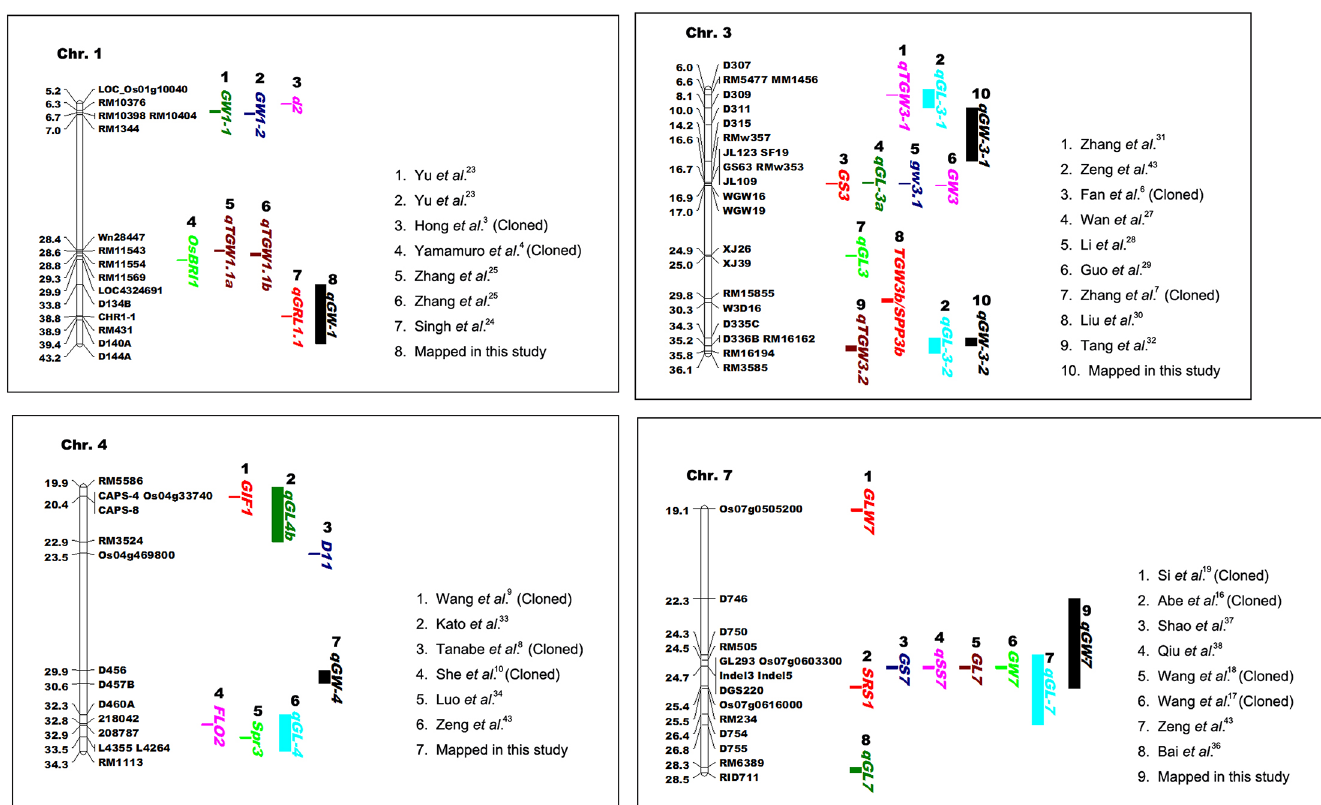
Fig 3. Comparison of the grain-shape- or grain-weight-related genes mapped on chromosomes 1, 3, 4, and 7 in the present and previous studies. Numbers to the left of the chromosome bar indicate the physicalposition (Mb) of the correspondingmarkers. The physicalpositionsof the markers were determinedusing the basic local alignmentsearch tool (BLAST) on the NationalCenter for BiotechnologyInformation (NCBI) website (https://www.ncbi.nlm.nih.gov/)and the Nipponbare (IRGSP-1.0) as the reference sequences.